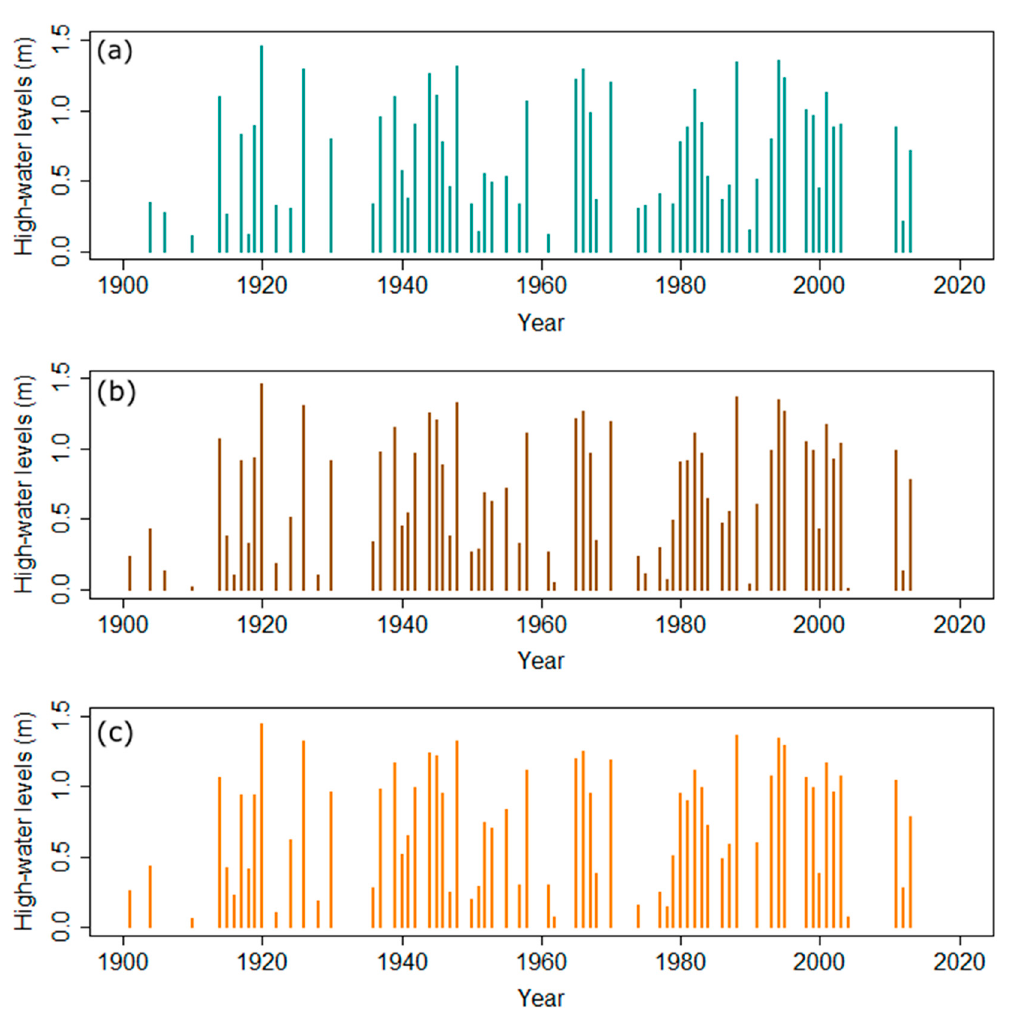
Figure 6. Flood peaks for values of memory decay rate µ equal to 0.10 year − 1 ( a , light green), 0.15 year − 1 ( b , brown), and 0.20 year − 1 ( c , orange).